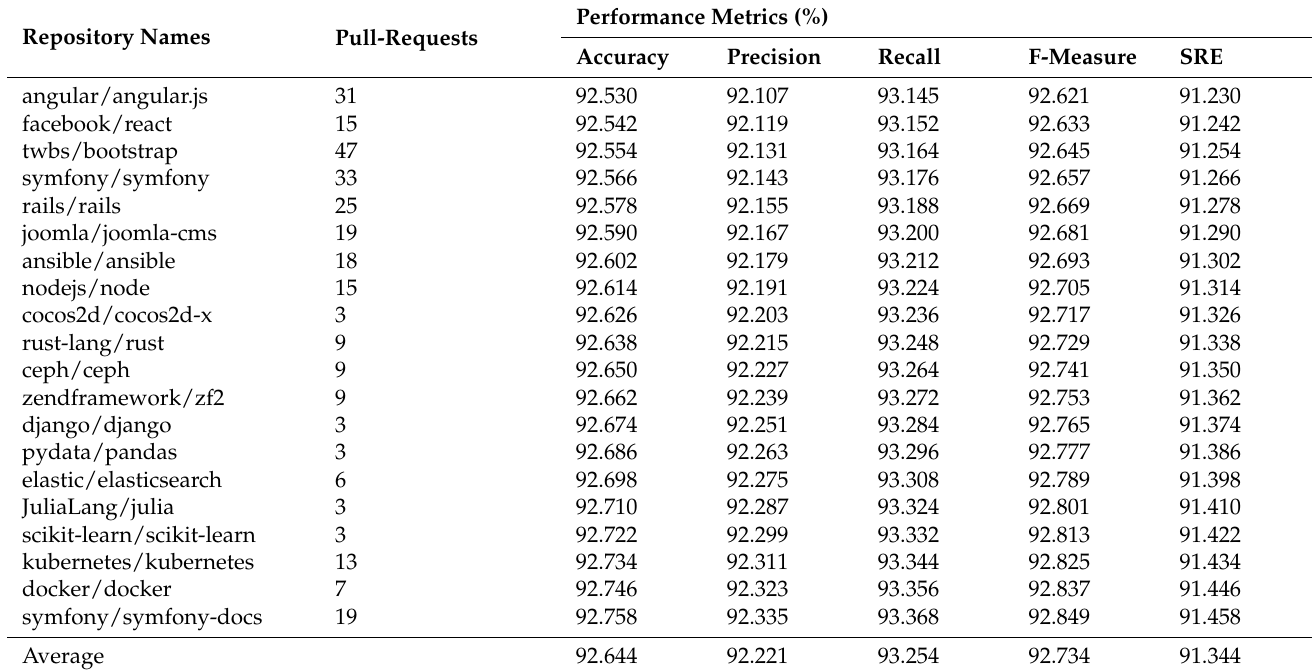
Table 4. Simulation results of our proposed GDN-GS technique.